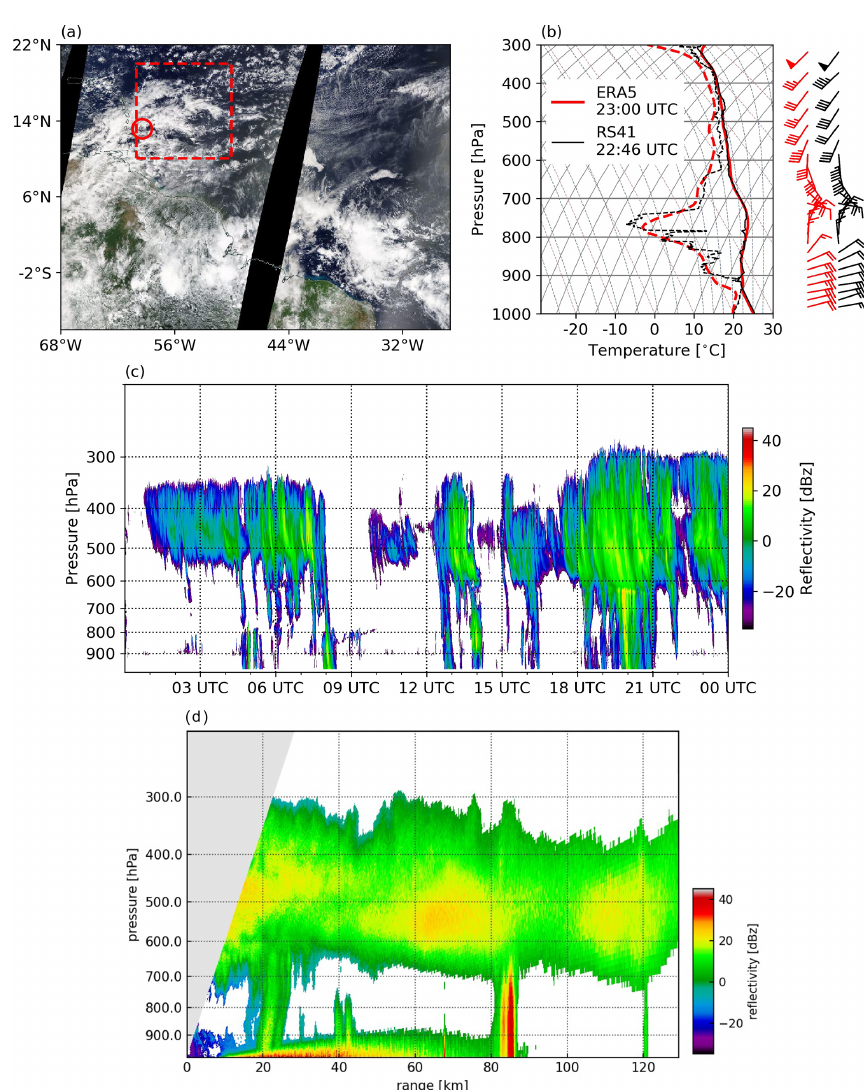
Figure 12. (a) MODIS Terra satellite image at about 14:30UTC on 14 February 2020 in the domain 8 ◦ S–22 ◦ N, 27–68 ◦ W, the location of Barbados (red circle), and the domain used for the domain-mean CRE calculation (10–20 ◦ N, 50–60 ◦ W; red box). (b) Vertical profiles of temperature (solid lines), dew point temperature (dashed lines), and wind (arrows) from ERA5 (thick red lines) and the atmospheric sounding (thin black lines) at about 23:00UTC on 14 February 2020. (c) Vertical profiles measured by the cloud radar (equivalent radar reflectivity of all hydrometeors) at the BCO on 14 February 2020. (d) Vertical cross section measured by the Poldirad at 19:15UTC on 14 February 2020 when the instrument was facing towards the BCO. Note that the shallow reflectivity layer between 10 and 90km is sea